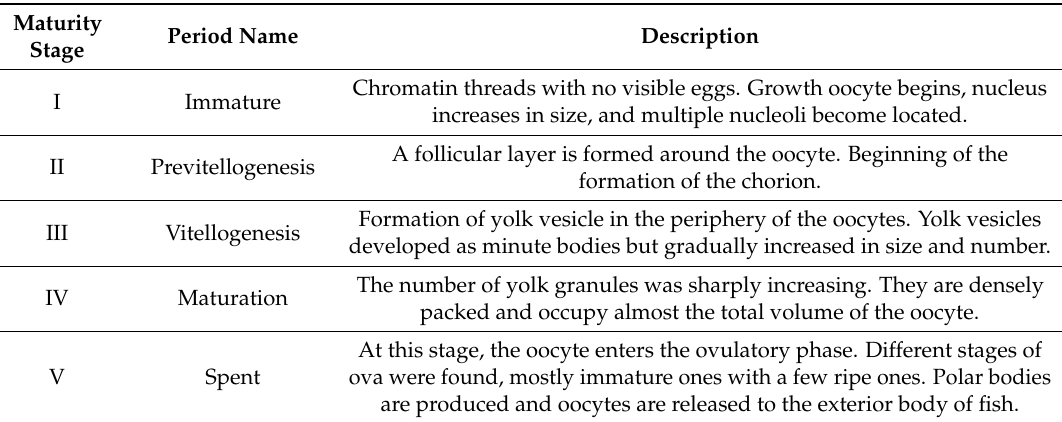
Table 5. Maturity stage of female gonads in P. sophore .